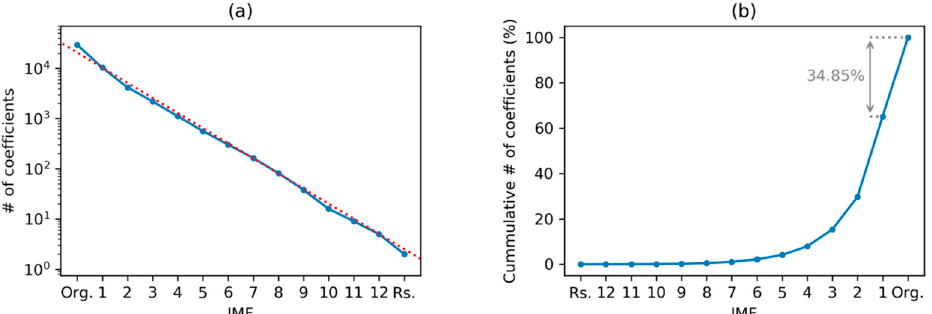
Figure 25. Electricity demand sequence compression: ( a ) Number of coefficients required to fully describe an IMF (dashed red line for halving this number); ( b ) cumulative number of coefficients when several IMFs are employed (as a % of the total number of values in the original sequence).